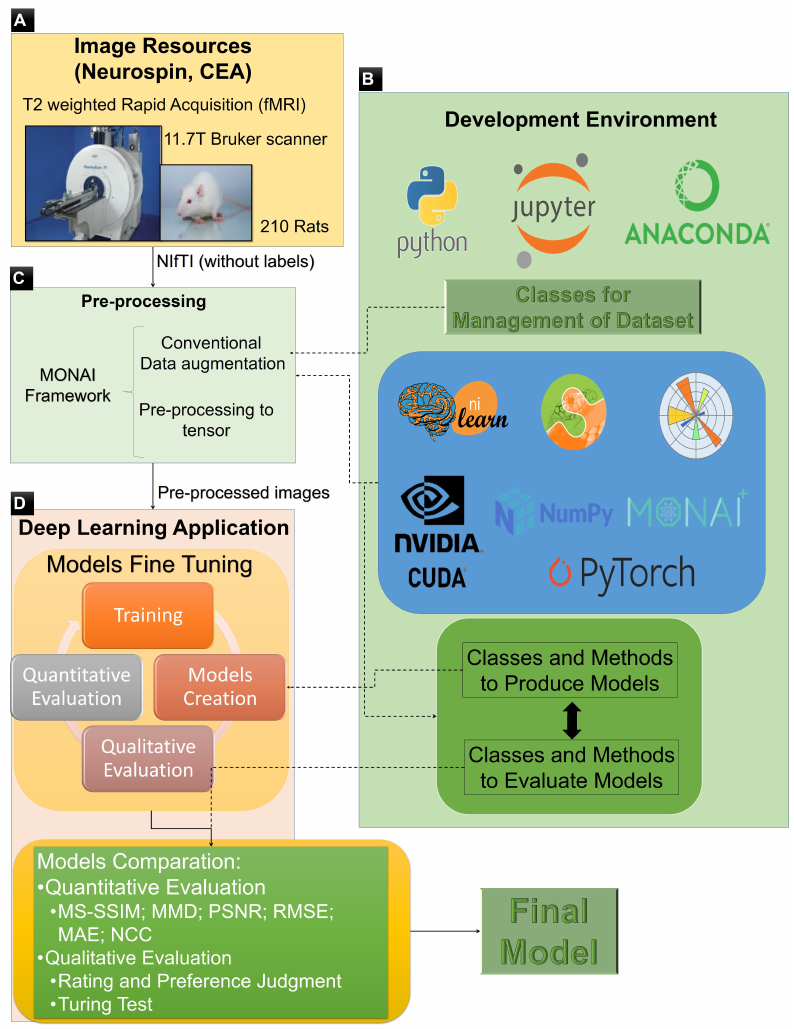
Figure 3. Overall training and evaluation process workflow, where ( A ) describes the image resources, ( B ) the development environment, ( C ) the pre-processing steps, and ( D ) the deep learning application.